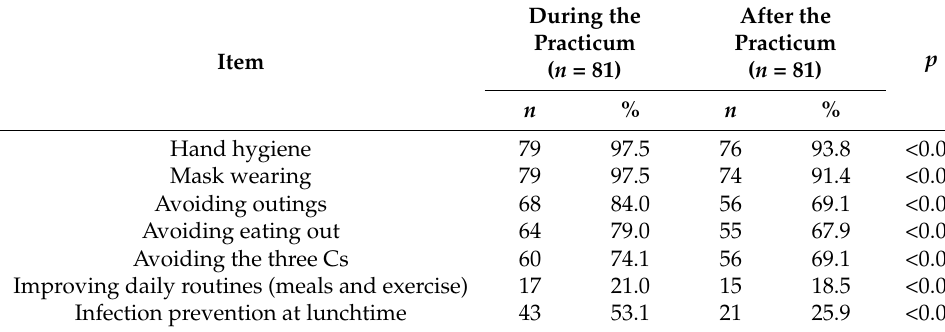
Table 6. A comparison of IPBs during and after the